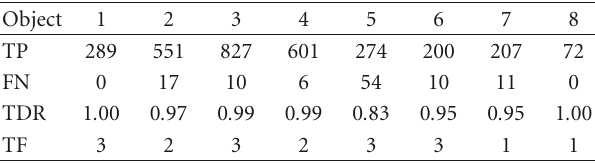
Table 3: Individual object performance results for the local feature tracking algorithm for S28-Cam5.